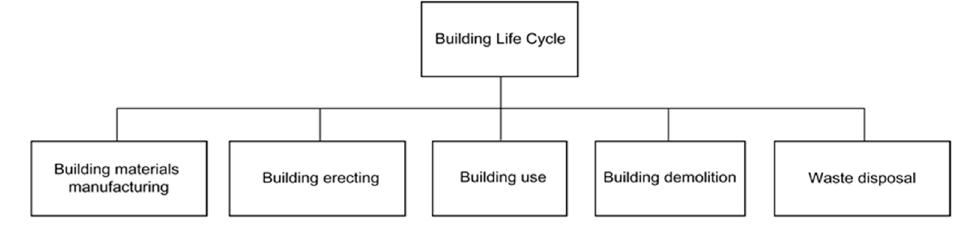
Figure 3. Five steps in the architectural full life cycle.